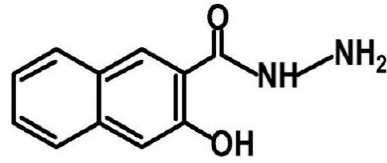
Figure 1. Chemical structure of 3-hydroxy-2-naphthoic acid hydrazide (HNH).